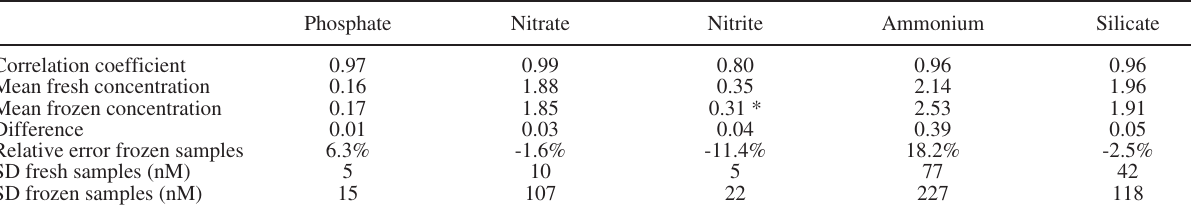
Table 5. – Summary of the results of the experiment on the freezing effect on seawater nutrient concentration ( m M). P -value for all the cor- relations <0.01. * indicates the existence of statistically significant differences ( P <0.05) between the mean concentration of freshly analyzed samples and that of frozen samples.